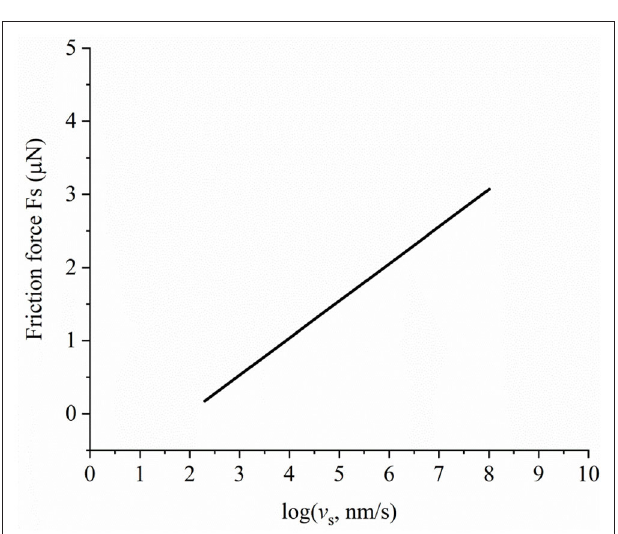
FIGURE 6 | Normal force as a function of surface separation under hydration contact.